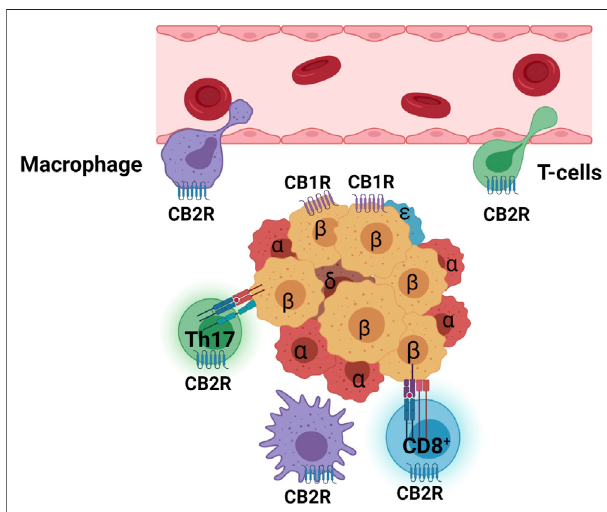
FIGURE3| ActivatedCB2Rsuppressesmacrophage(purple)andTcell (green) in fi ltration from endothelium barrier of blood vessel and inhibits M1 macrophages (purple ameba shape), self-reactive HMC-I CD8 + T cells (blue with halo), and CD4 + Th17 cells (green with halo). Islet cell types are marked with Greek letters ( α , β , δ , ε ). Purple serpentine represents CB1R in β - cells and blue serpentine CB2R in immune cells.